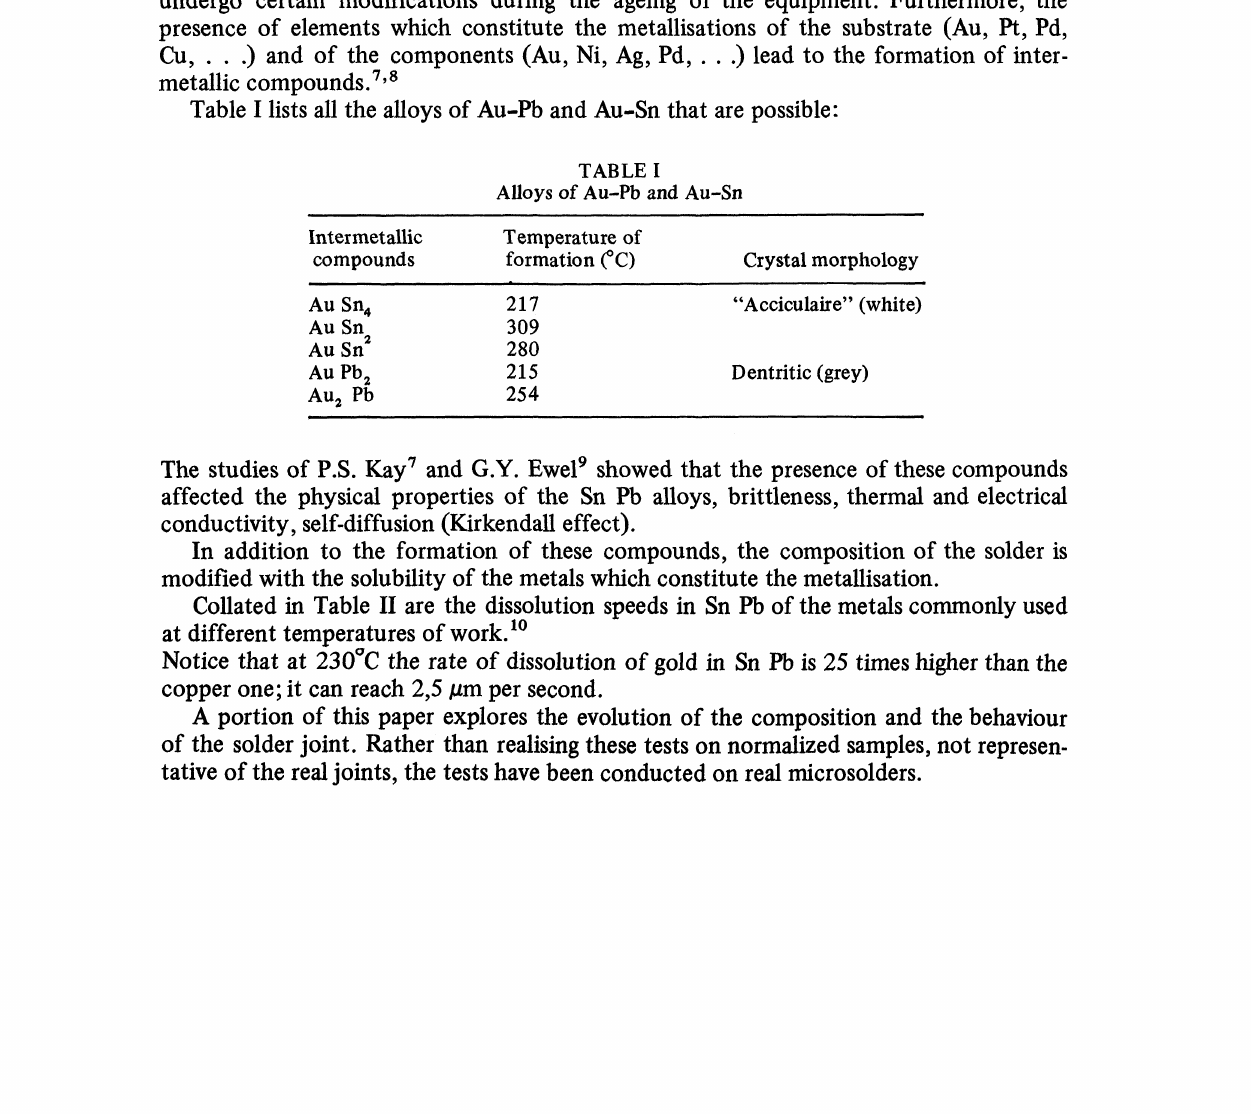
/ Enamaled see[ (Iside) Atumina / stet(2sid2//p! Enamated 5( / / / 500 Nbr. of cyctes 1000 100 Number of solder failures versus thermal cycle [from--50C (30mn) to +125C (30mn)].